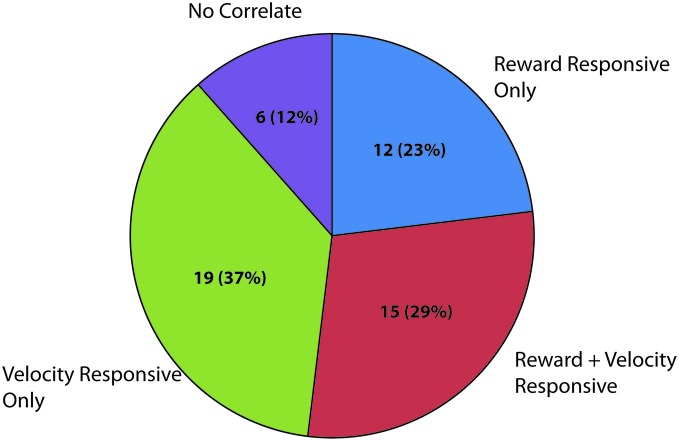
Summary of significantly responding LFP channels during spatial navigation to reward. Numbers represent significantly modulated channels in each category across sessions followed by the percentage of the total number of recorded LFP signals. Velocity responsive channels were defined as a significant correlation (Pearson’s linear) of instantaneous velocity with power in dBs in the theta band (4–8 Hz). Reward related channels were defined as channels which had significantly elevated theta power in the 200 ms surrounding reward arrival as compared with an equal sized time bin 1800 ms after reward encounter when similar velocities and positions were observed.